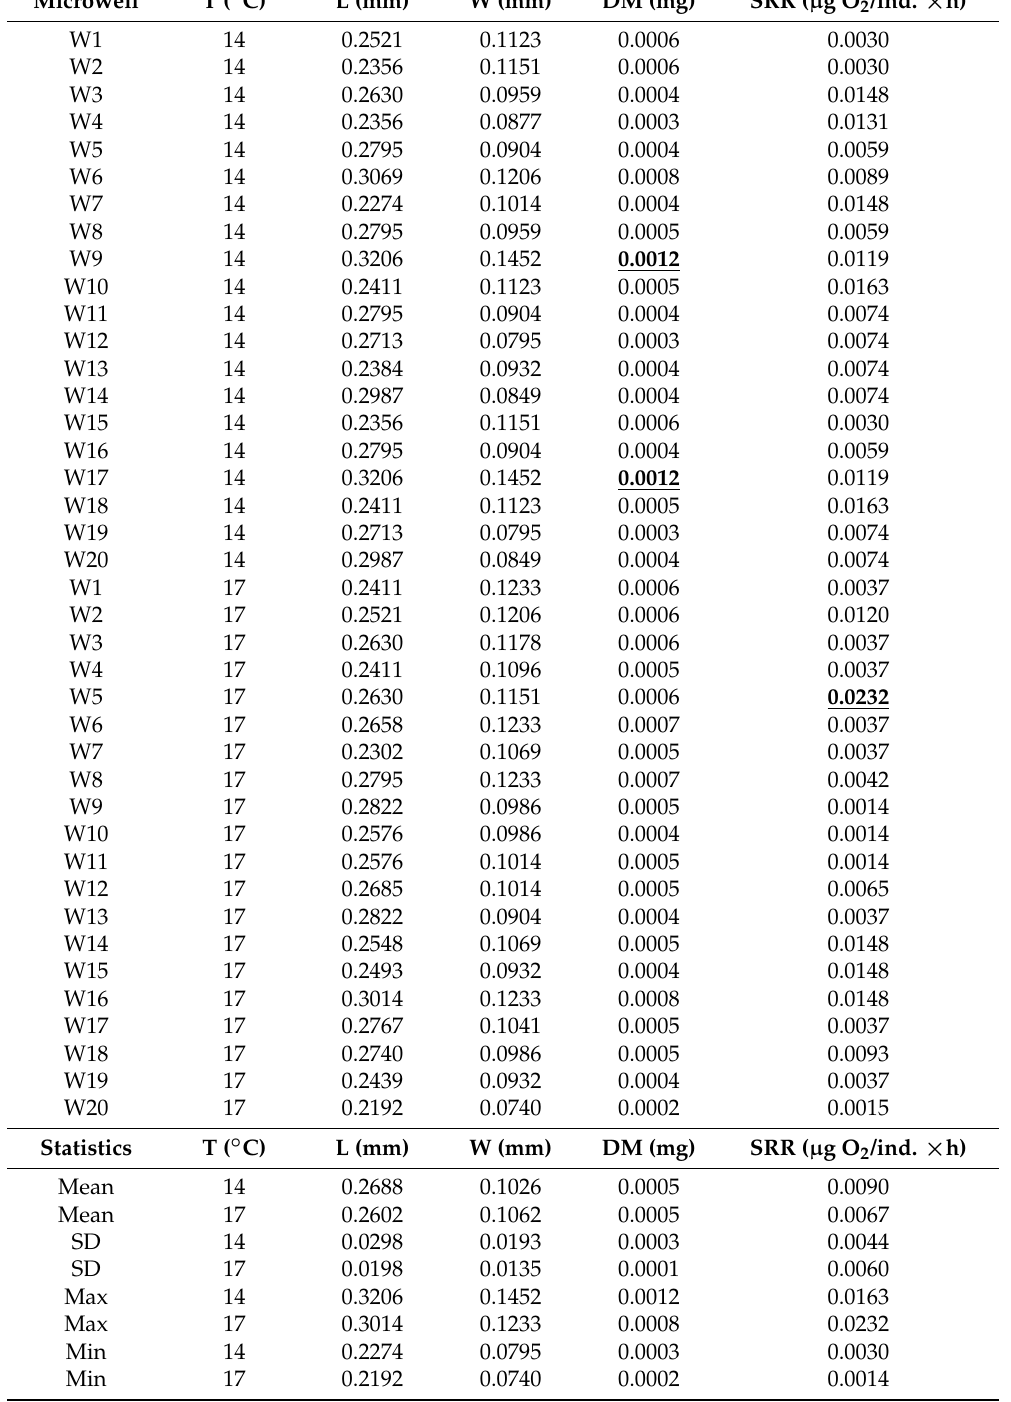
Table 1. Prosome length (L), prosome width (W), dry mass (DM) and standard respiration rates (SRR) of the 40 individuals of Diacyclops belgicus (Kiefer, 1936) involved in the respirometric trials at two temperatures (T). Mean, standard deviation (SD) and minimum and maximum values are also shown. SRR are in µ g of oxygen per individual per hour. Outliers above the upper inner fence are in bold and